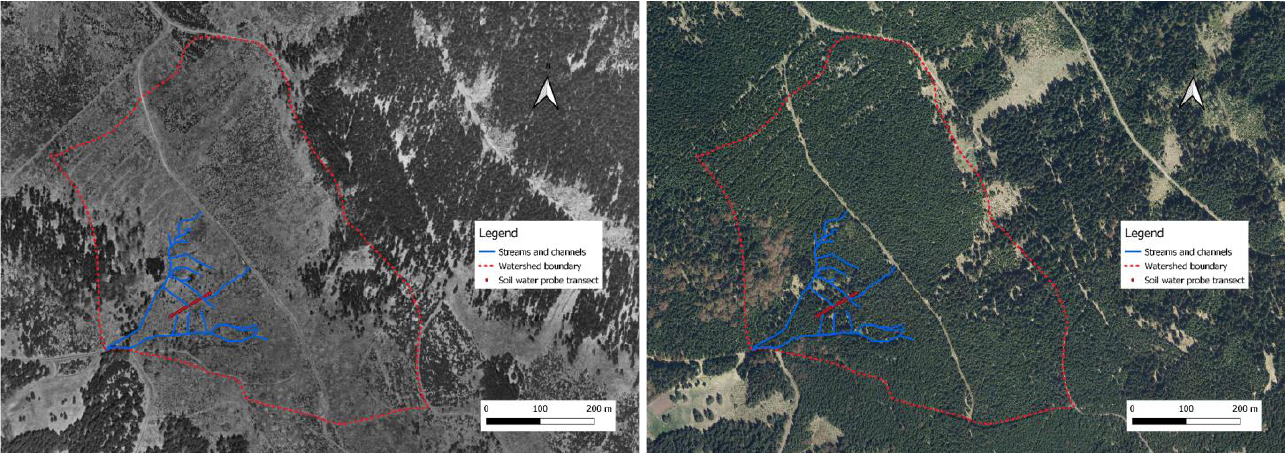
Figure 5. Forest cover of the experimental catchment in 2000 ( left ) and 2021 ( right ).